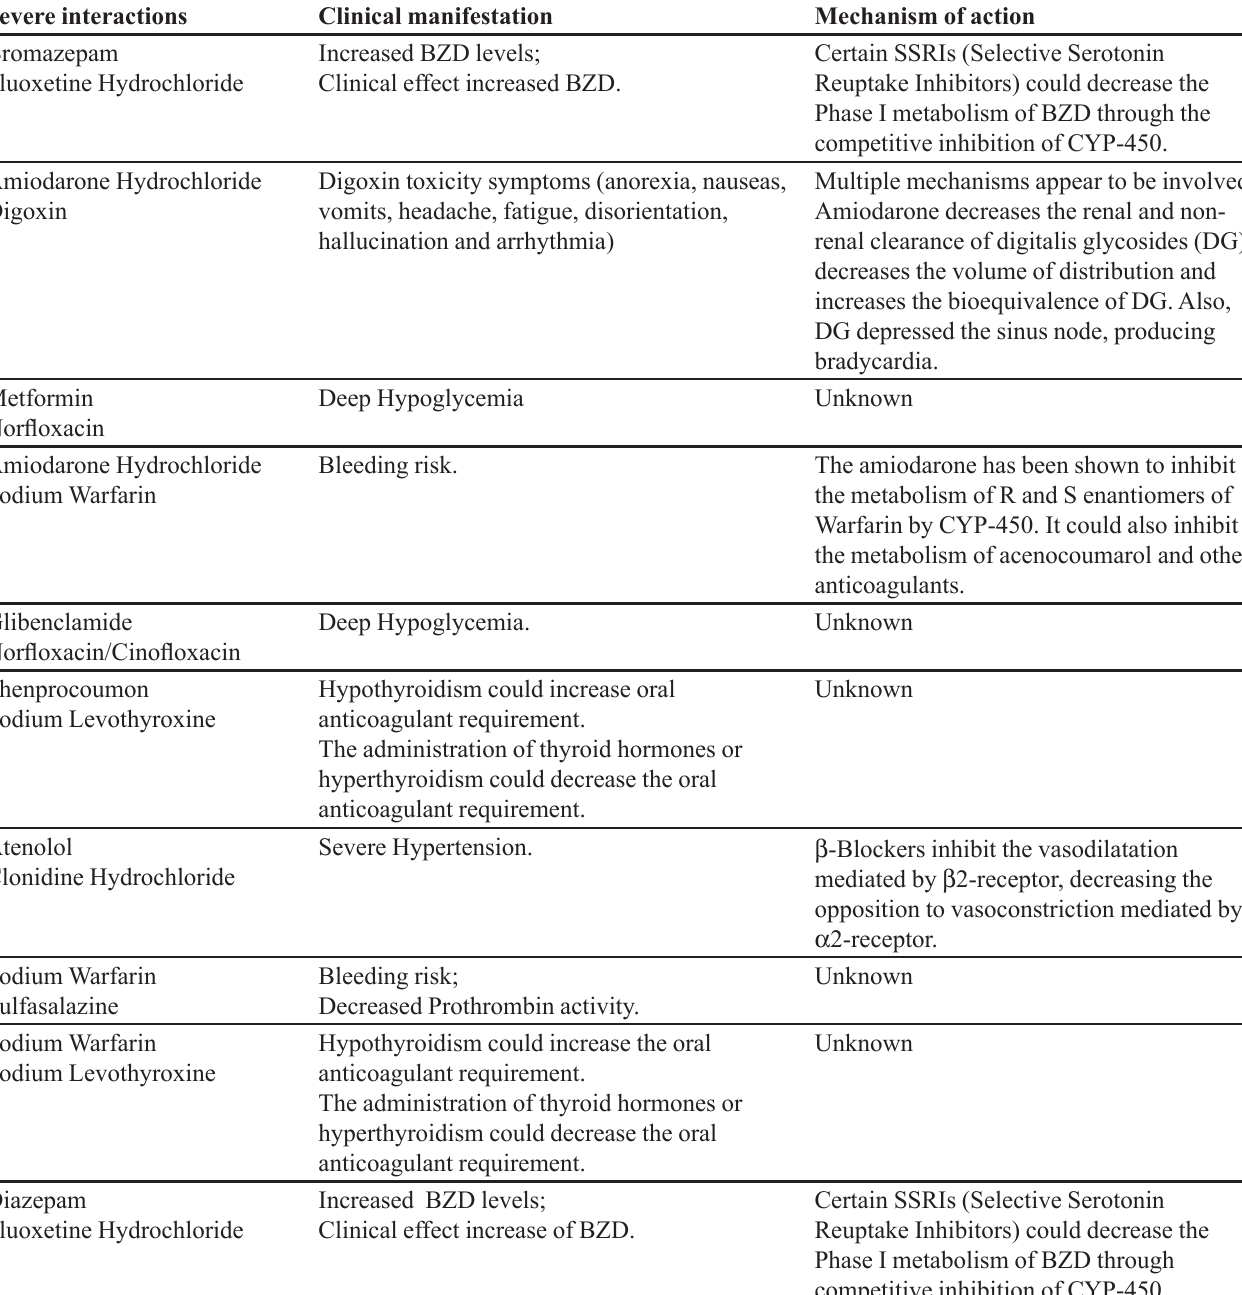
TABLE VI - Clinical manifestations and mechanism of action of most severe potential drug-drug interactions Severe interactions Clinical